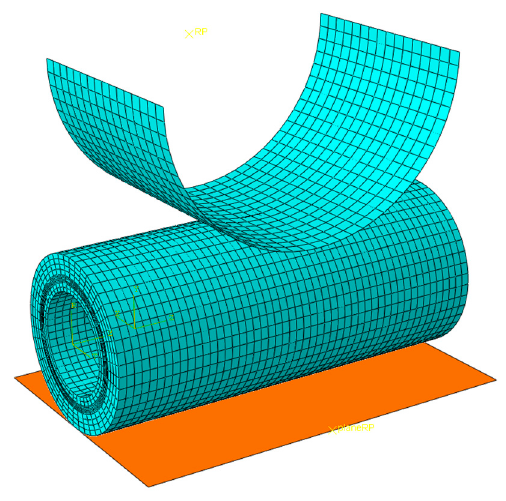
Figure 5. The set up of the compressing simulation.